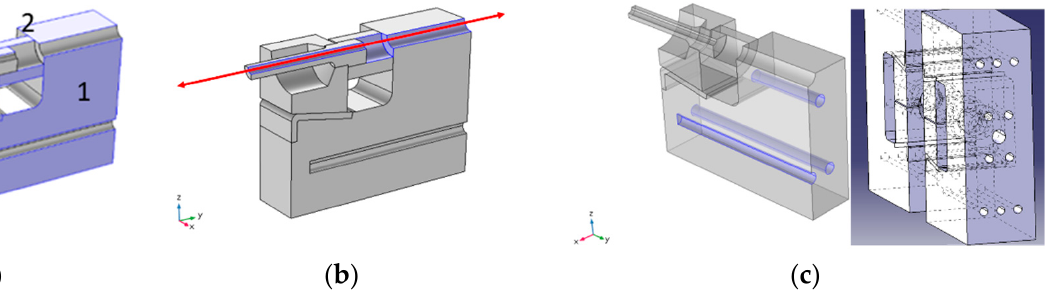
Figure A1. ( a ) The 3 planes of symmetry of the geometrical model, ( b ) Circulation of air for the cooling phases during the cycle, ( c ) Circuit of continuous water-cooling of the jaws at 20 °C in or- der to maintain its temperature.